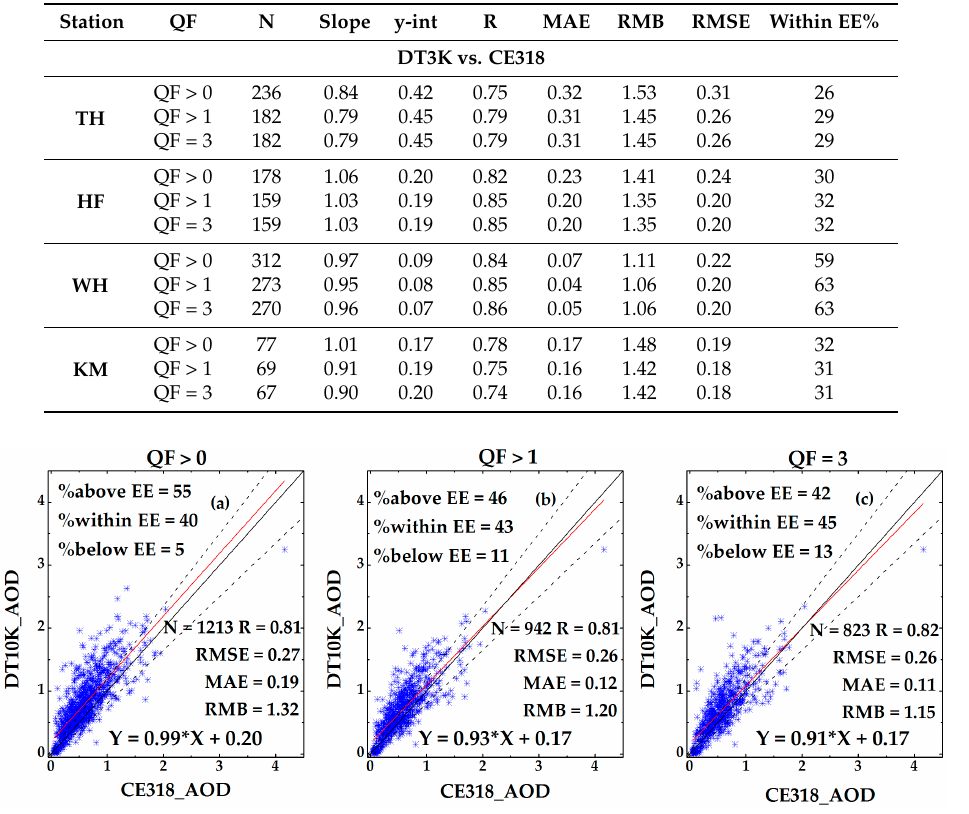
Figure 3. As in Figure 2, but comparison of the DT10K AOD products. The DT10K AOD retrievals with QF > 0, QF > 1 and QF = 3 are presented in ( a – c ), respectively. Table 4. As in Table 3, but comparison of the DT10K AOD products.